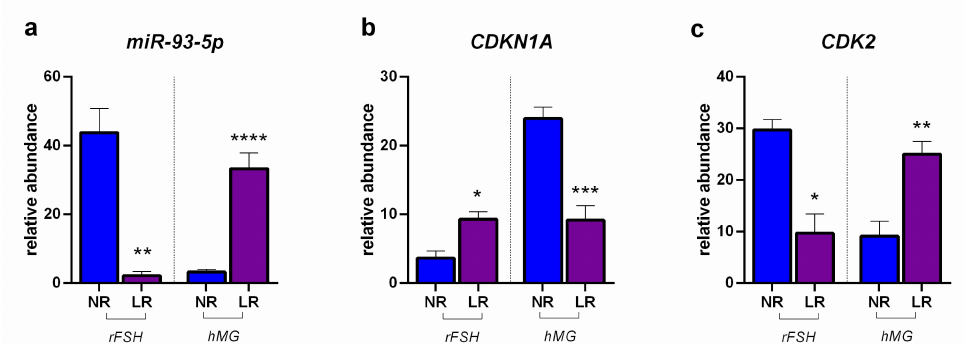
Figure 3. Expression profiles: ( a ) miR-93-5p; ( b ) CDKN1A : cyclin dependent kinase inhibitor 1A; ( c ) CDK2 : cyclin dependent kinase 2. Results are reported as mean ± standard deviation. Statistical significance was set at p < 0.05 and calculated by Student’s t -test. Asterisks above columns indicate statistical differences between NR and LR groups. * = p < 0.05; ** = p < 0.01; *** = p < 0.001; **** = p <